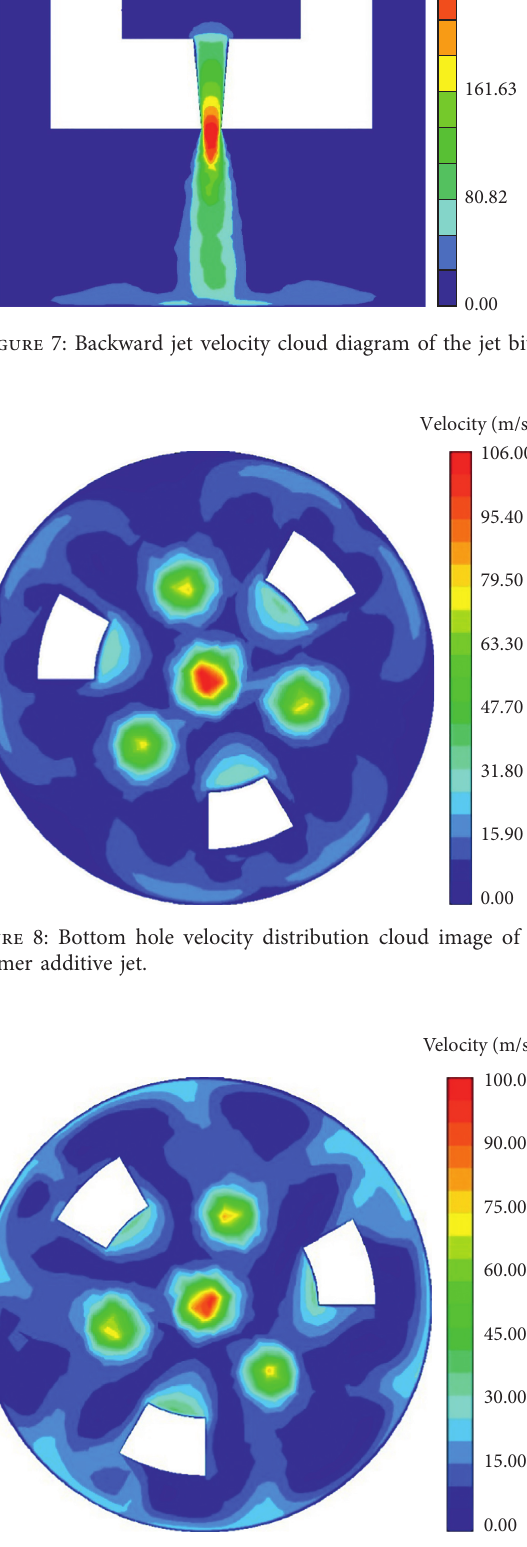
Figure 9: Bottom hole velocity distribution cloud image of the pure water